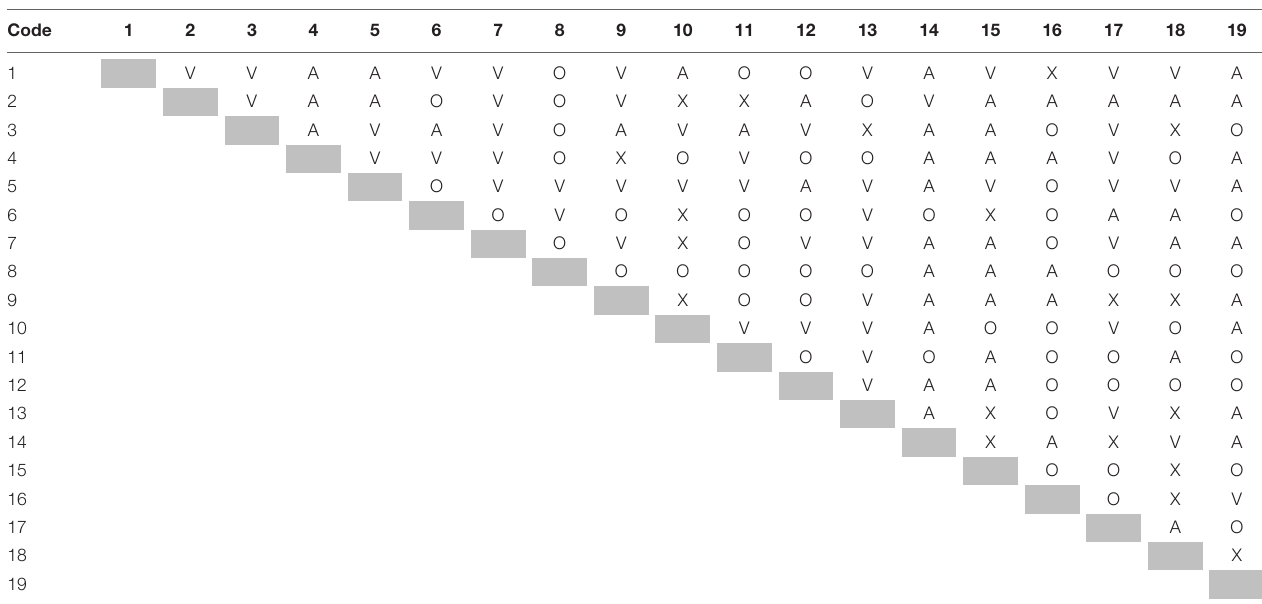
TABLE 2 | Structural self-interaction matrix (SSIM).